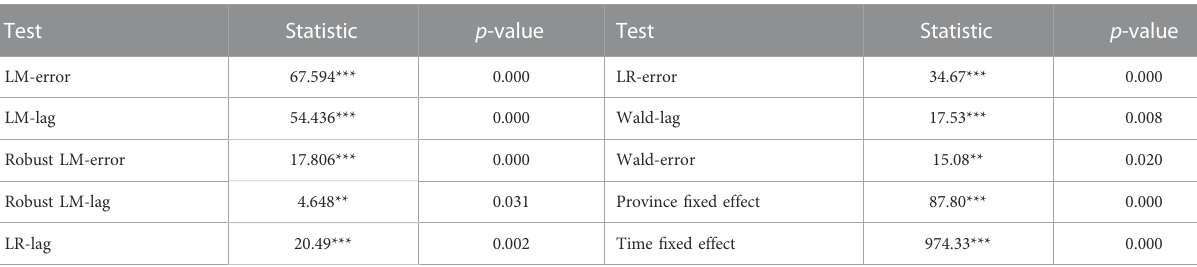
TABLE 3 Test of spatial model